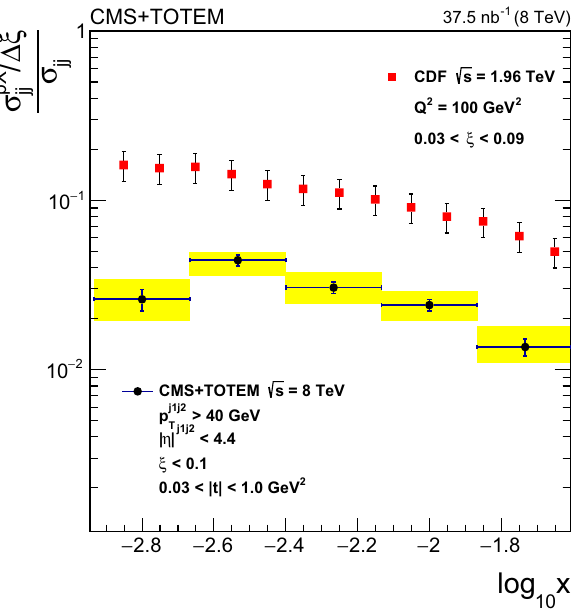
Fig. 6 Ratio per unit of ξ of the single-diffractive and inclusive dijet cross sections in the kinematic region given by ξ < 0 . 1 and 0 . 03 < | t | < 1GeV 2 . The vertical bars indicate the statistical uncertainties and the yellow band indicates the total systematic uncertainty. The red √ s = 1 . 96TeV for squares represent the results obtained by CDF at jets with Q 2 ≈ 100GeV 2 and | η | < 2 . 5, with 0 . 03 < ξ < 0 .